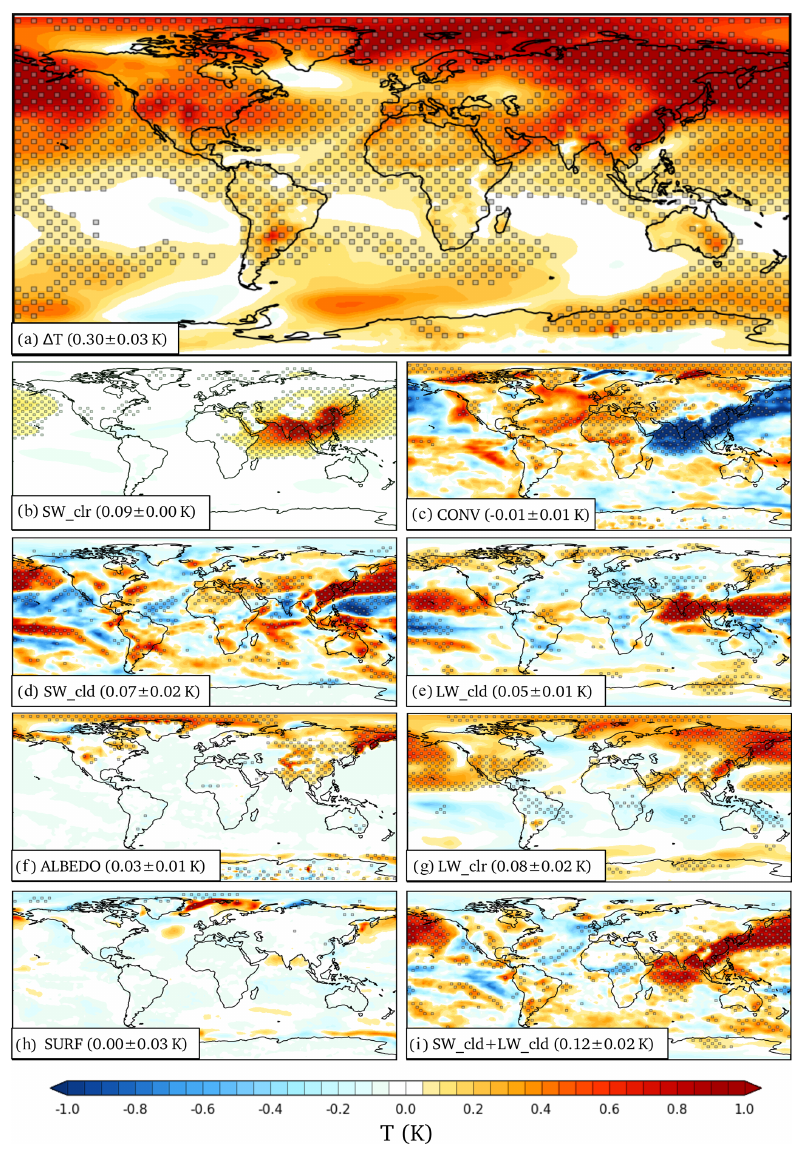
Figure A3. As Fig. A2 but for the NorESM1